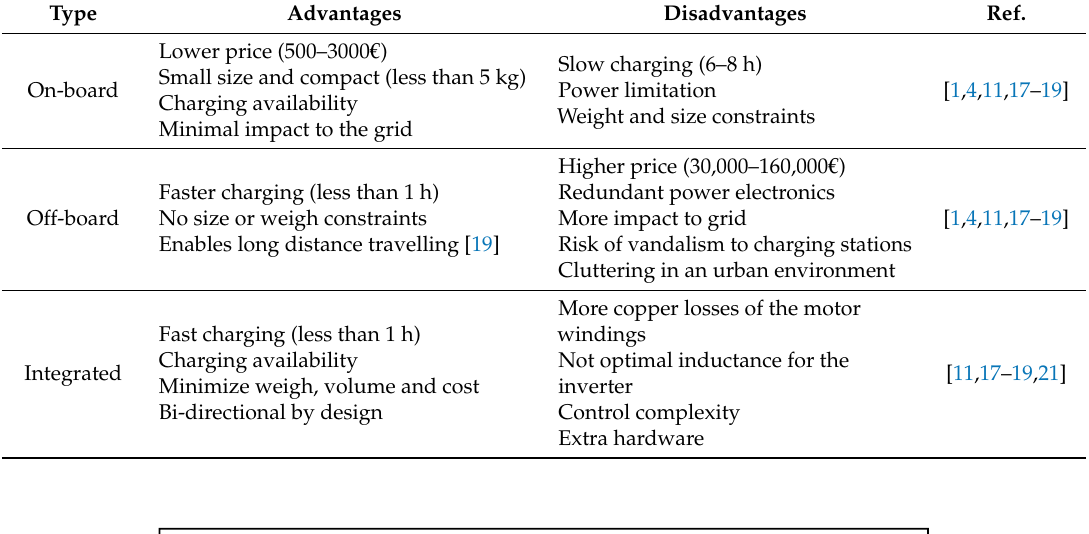
Table 2. Comparison between On-Board, Off-Board and Integrated chargers.